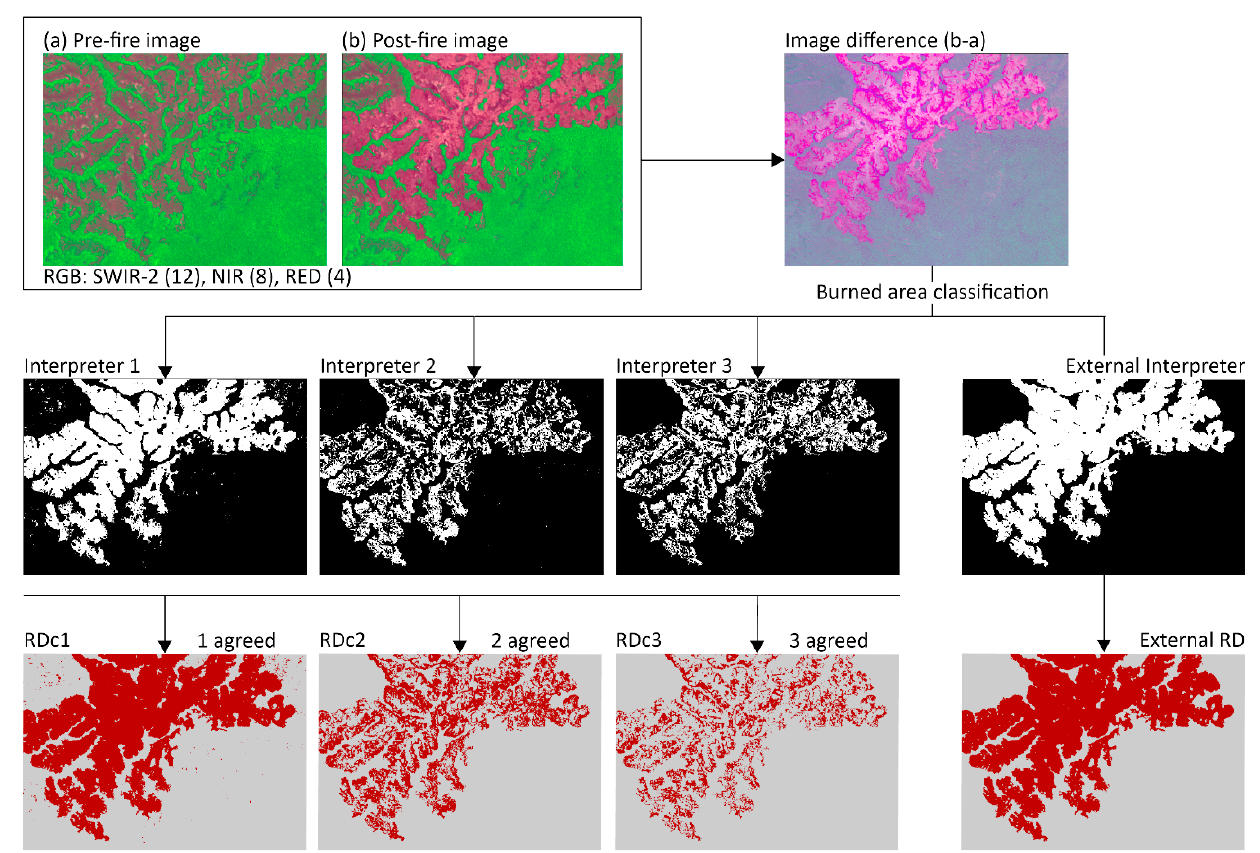
Figure 2. Illustration of the reference datasets and reference data collection generation process. Pre- and post-fire images (RGB composition: SWIR-2, NIR, RED) were used to derive the image of difference, which was classified by each of the four interpreters. Reference datasets obtained for the three RAISG analysts were used to create the three reference data collections (RDc).